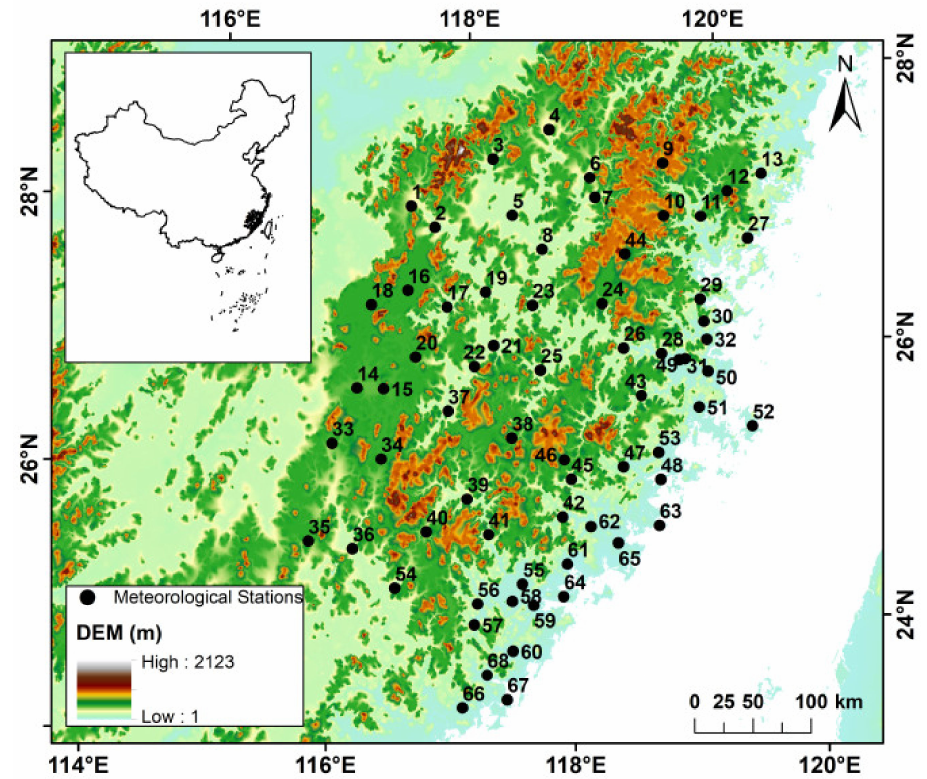
Figure 1. Location of meteorological stations (black dots) and topography in the study